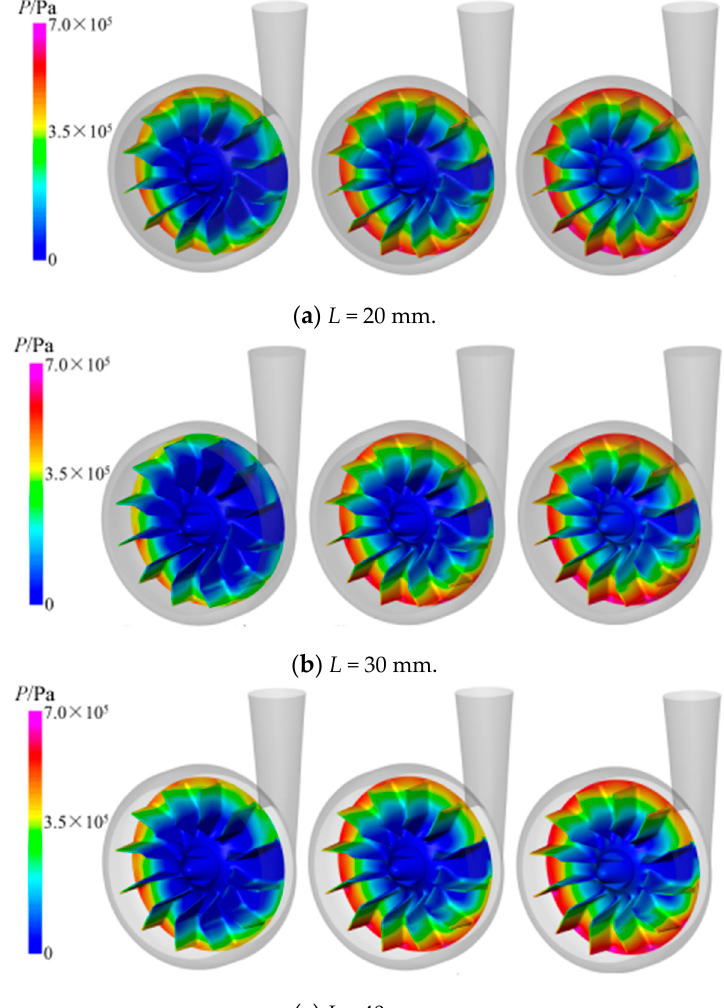
Figure 5. Internal ( P ) distribution of the pump with different L values under the three cases of inlet total pressure. total